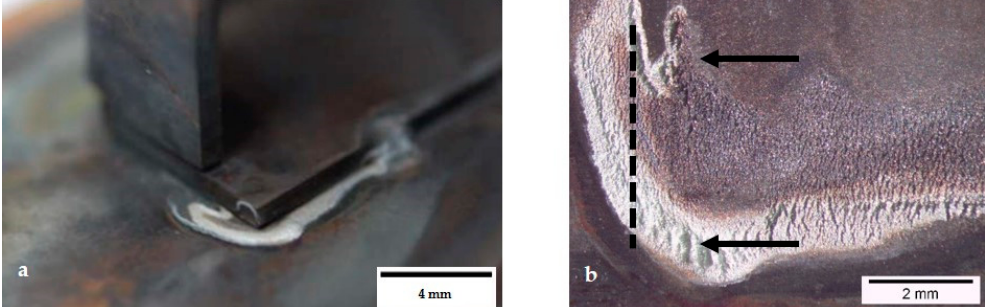
Figure 4. Macro- and microscopic images of corroded specimen after 100 h, 1.4509 grade (cleaned from deposits). ( a ) macroscopic image, ( b ) microscopic image.